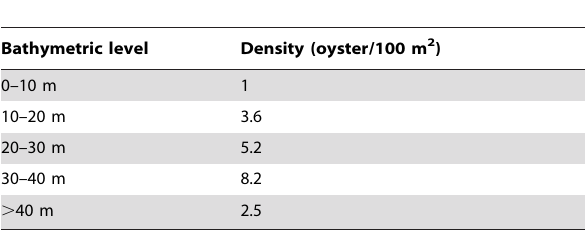
Table 1. Density of wild pearl oyster according to the bathymetric level (after